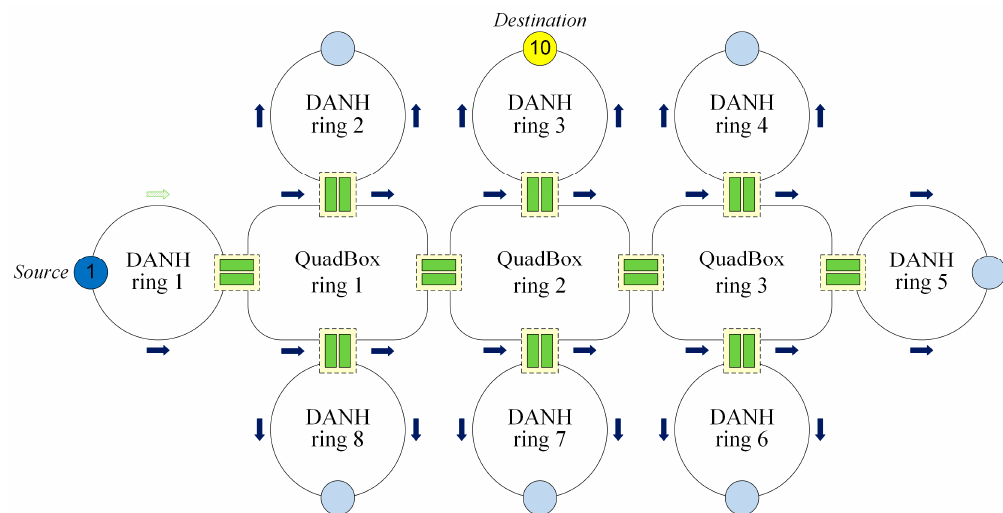
Figure 3. Forwarding a unicast frame using the quick removing (QR) technique.